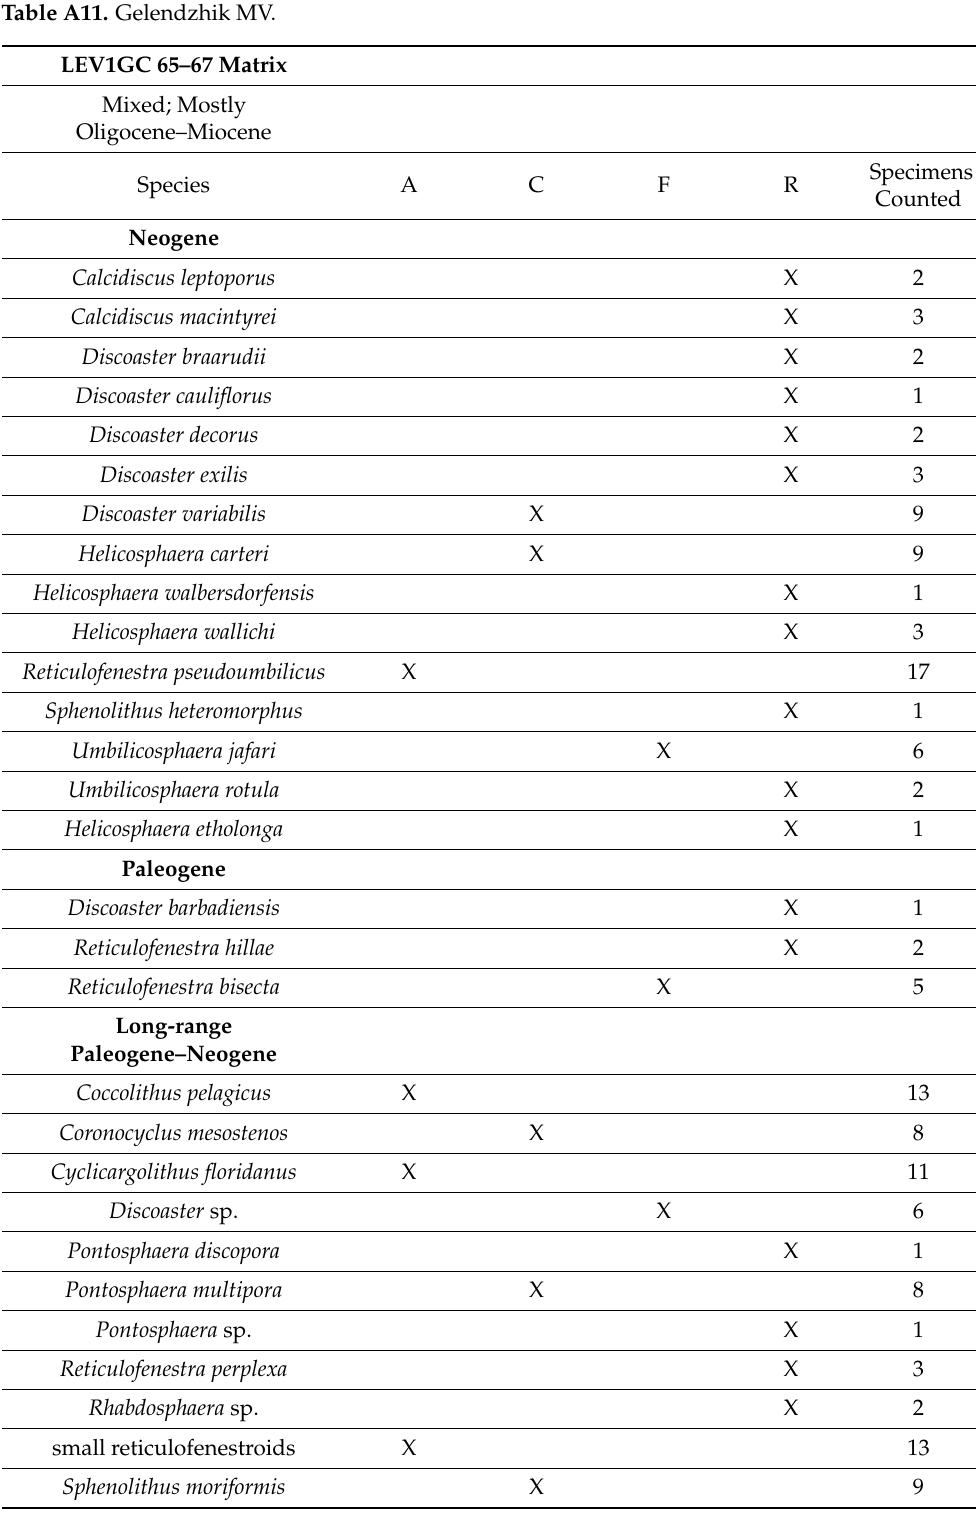
Table A11. Gelendzhik